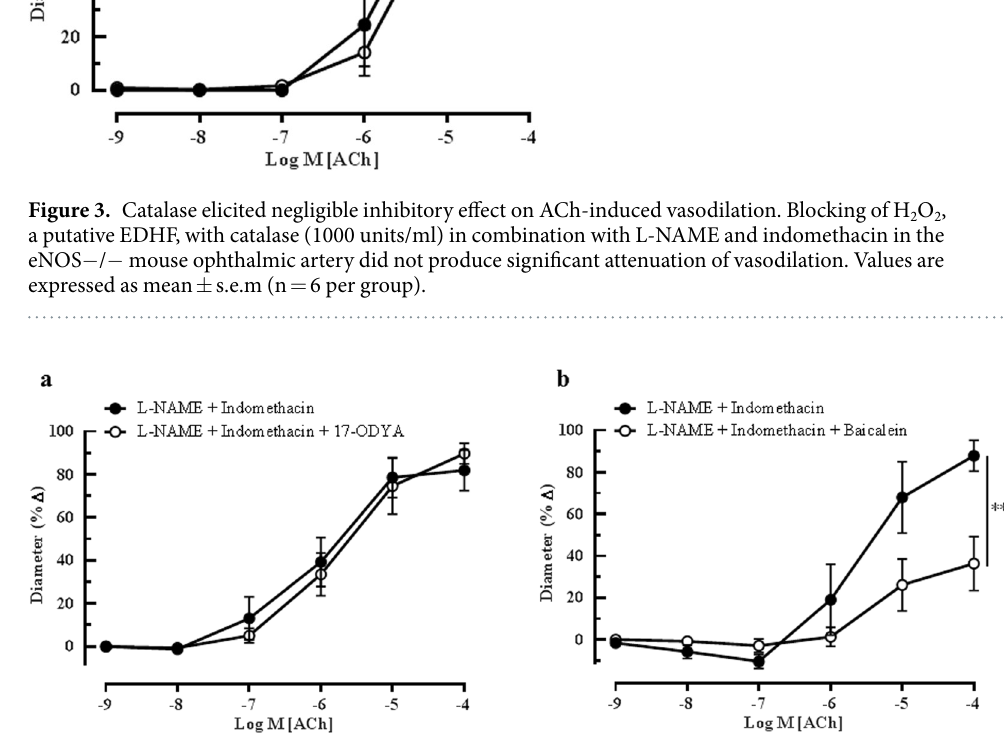
Figure 4. Endothelium-dependent relaxation of the ophthalmic artery attributed to EDHF via arachidonic acid metabolites. Concentration-response curves to ACh (10 − 9 –10 − 4 M) in the presence of ( a ) CYP 450 inhibitor, 17-ODYA and ( b ) LOX inhibitor, baicalein. Blocking of the CYP 450 pathway conferred a negligible inhibitory effect on ACh-induced vasodilation, whereas, inhibition of the LOX pathway elicited significant attenuation of vasodilation. Values are expressed as mean ± s.e.m (n = 6 per group; *** P < 0.001, L-NAME and indomethacin vs L-NAME and indomethacin and